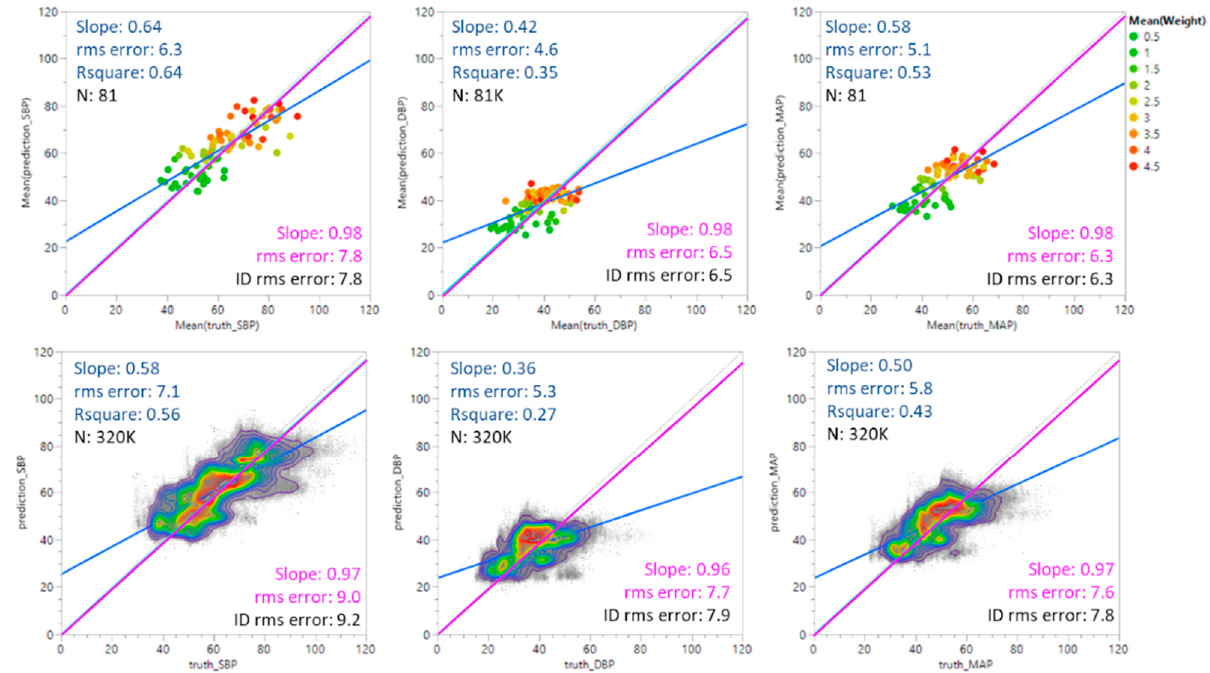
Figure 4. Predicted BP values vs. ground truth values. The blue line represents an unconstrained linear fit to the data. The green line is a linear fit constrained by a zero-intercept. The grey line is the identity (ID) fit where the predicted values equal the ground truth values. The figures were generated using JMP software version 16.2.0. Table 6 summarizes the degree of agreement for SBP, DBP, and MAP. Table 6. Summary of degree of agreement for SBP, DBP, and MAP including agreement with FDA